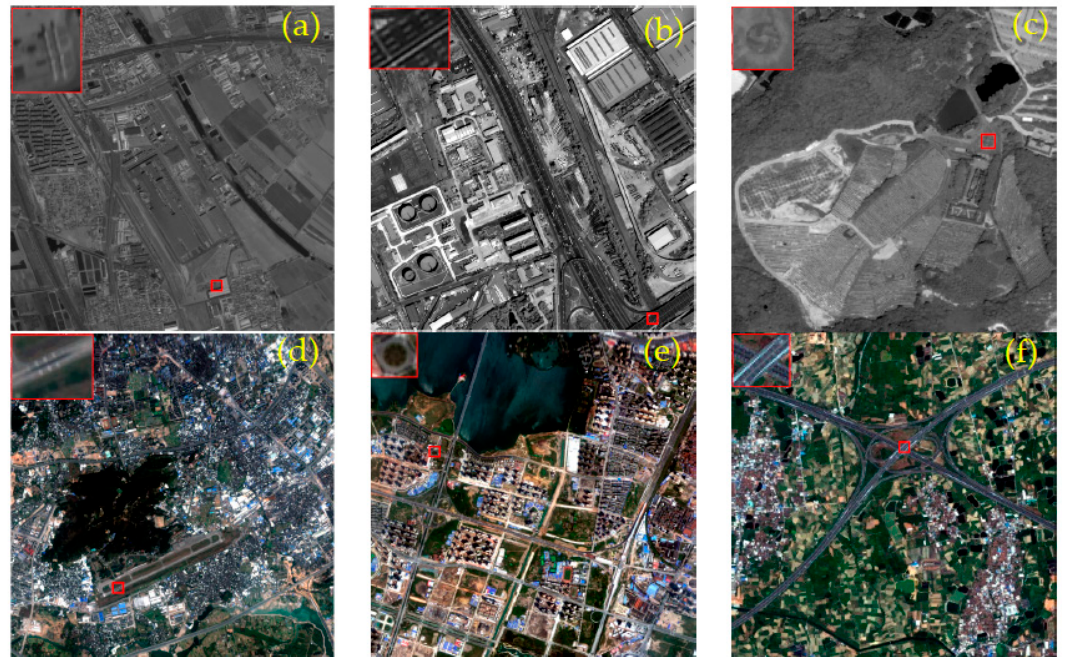
Table 5. Parameters of experimental imagery.